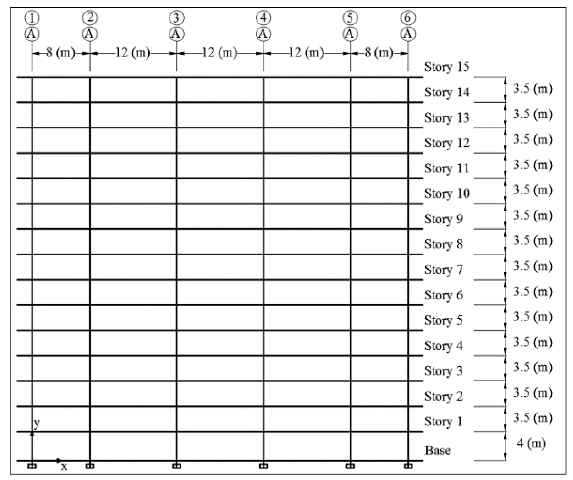
Figure 2. Building elevation at grid line A.